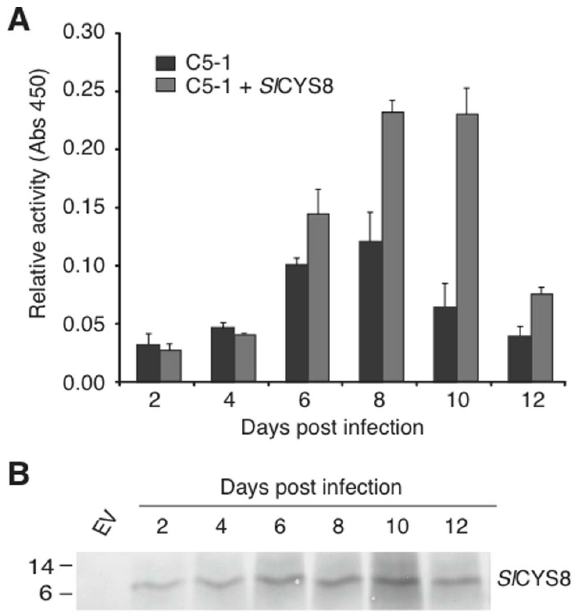
Figure 6. Time-course accumulation of biologically active C5-1 expressed alone or along with Sl CYS8. Samples (from Leaf 2, Leaf 3 and Leaf 4) were collected at 2, 4, 6, 8, 10 and 12 dpi from leaf tissue transiently expressing C5-1 alone or along with Sl CYS8. (A) The relative activity of C5-1 was measured by ELISA on a total soluble protein basis. Each value is the mean of three independent (biological) replicates 6 SE. (B) Immunodetection of Sl CYS8 at different time points following SDS-PAGE of leaf proteins under reducing conditions. The cystatin was detected with polyclonal primary antibodies raised in rabbit and an alkaline phosphatase-conjugated goat anti-rabbit secondary antibody. EV, mock infiltration with an empty vector.